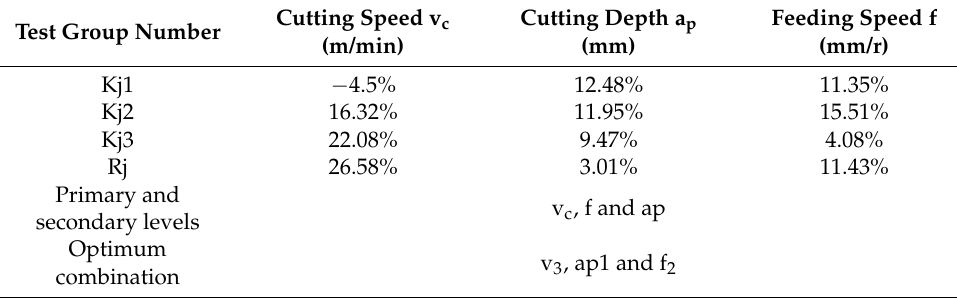
Table 6. Tool wear depth difference